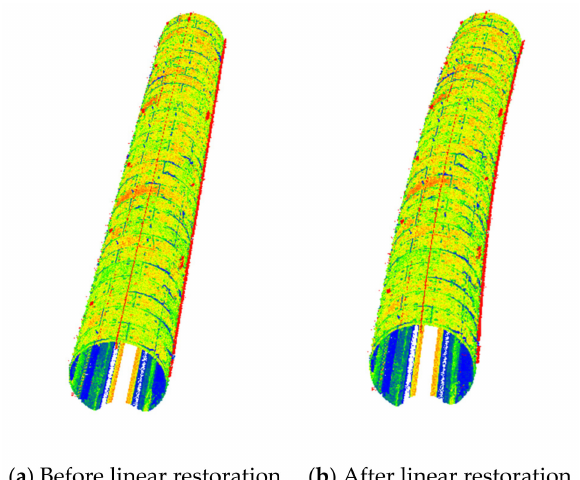
Figure 12. Comparison results of tunnel linear before and after reconstruction.